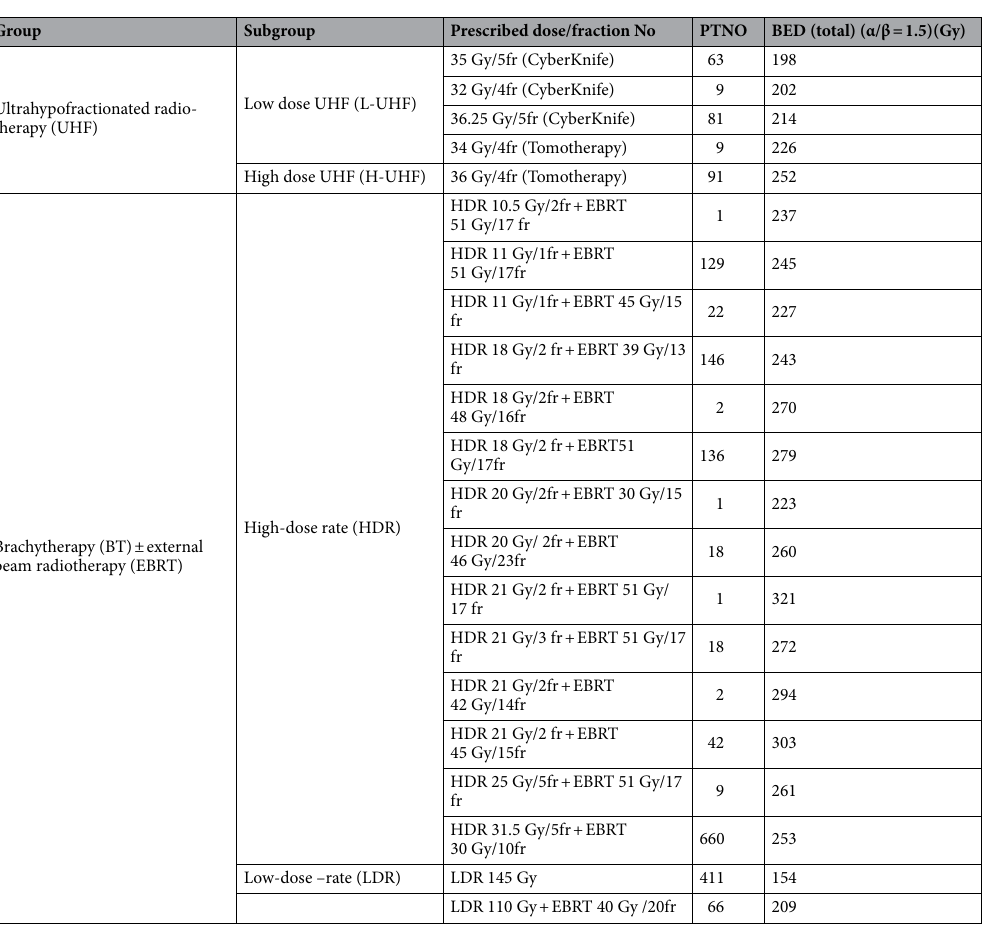
Table 2. Detailed treatment schedule. BED = nd(1 + d/[α/β]): n Number of treatment fractions, d Dose per fraction in Gy, α/β = 1.5, BT brachytherapy, EBRT external beam radiotherapy, UHF